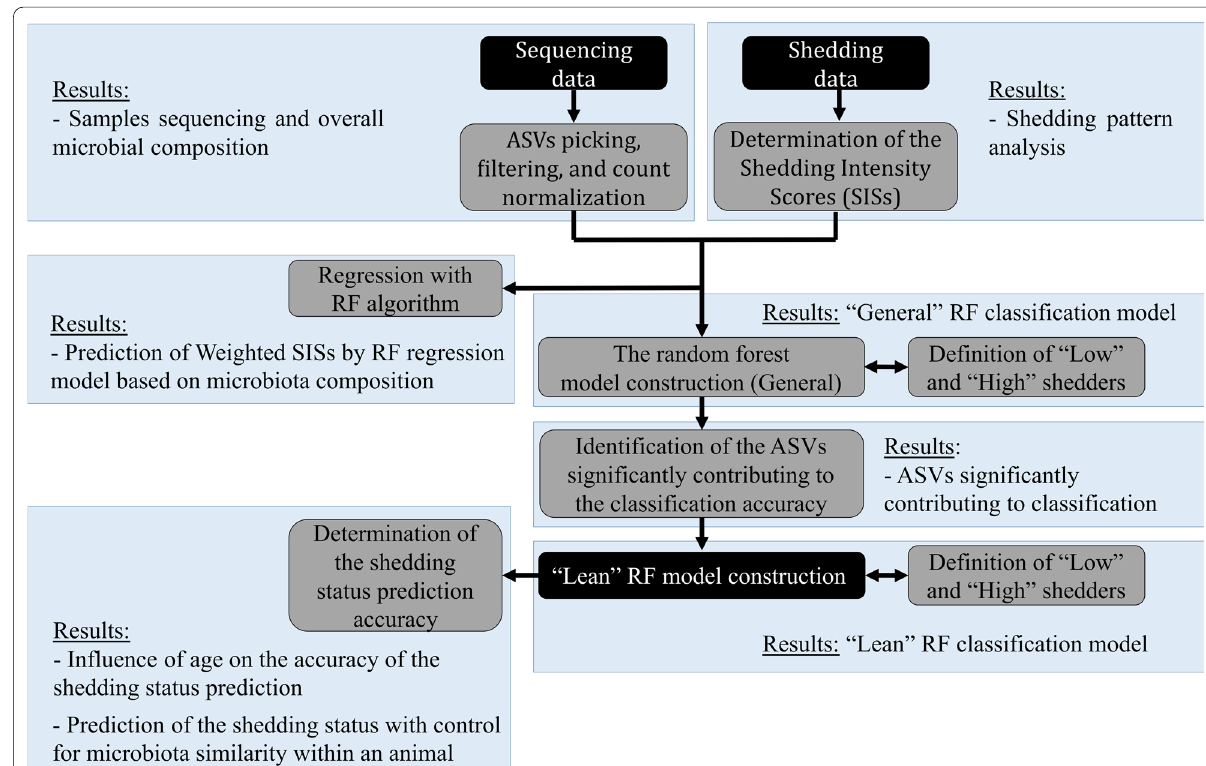
Fig. 1 Overview of the data analysis workflow. Black boxes indicate input data and the final model; grey boxes correspond to data processing steps and arrows show connection between them. Names of the grey boxes are identical to the titles of data analysis subsection in the Material and Methods section. Blue rectangles show correspondence between data analysis steps and the Results